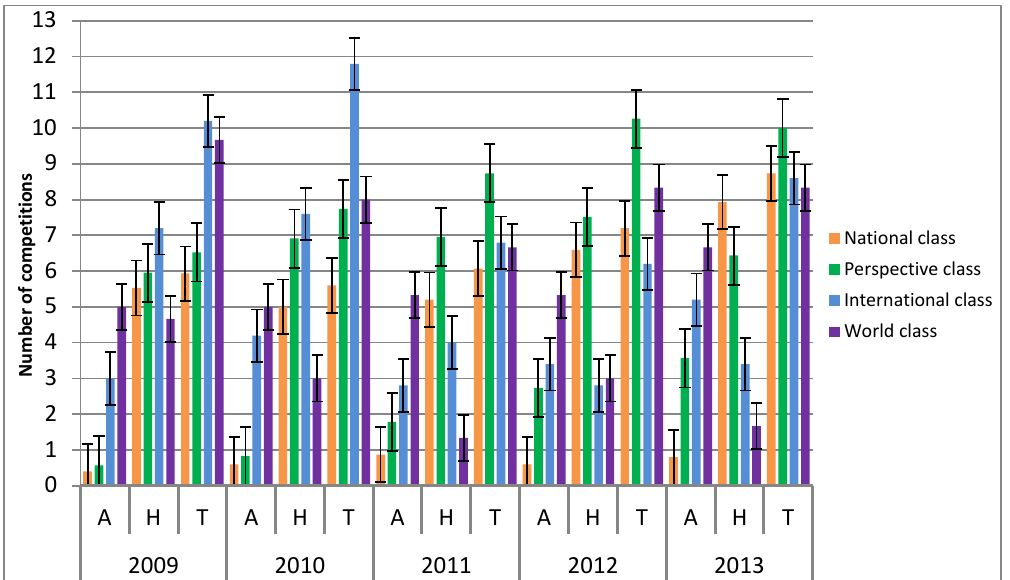
Figure 1. The distribution of abroad (A), home (H) and total number of competitions (T) of different categorisation classes from years 2009 to 2013.